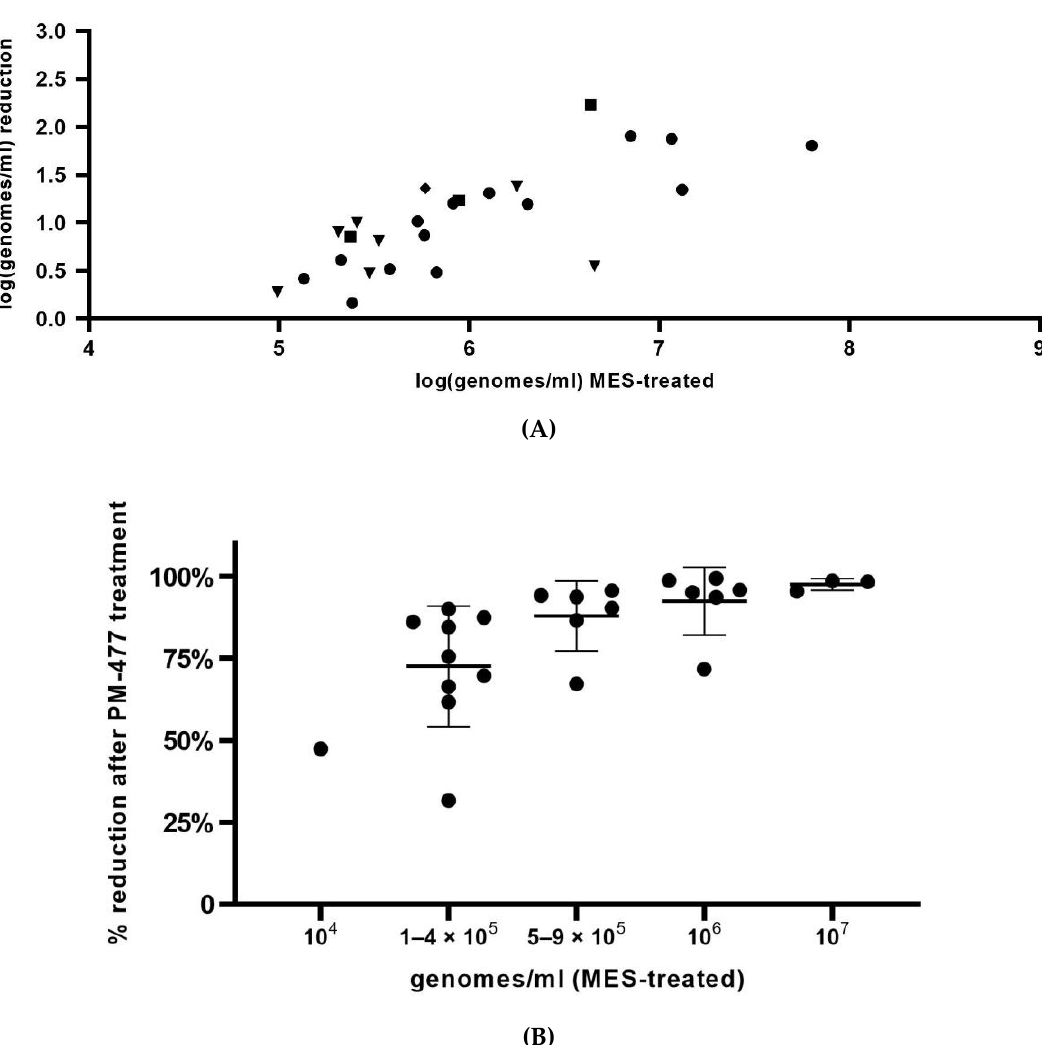
Figure 4. ( A ) Reduction of number of Gardnerella genomes by overnight treatment of vaginal sam- ples with 100 µg/mL PM-477, as assessed by Gardnerella species-specific qPCRs, calculated as: log(MES/PM-477). ( B ) Percentage of reduction of Gardnerella genomes by overnight treatment of vaginal samples with 100 µg/mL PM-477, as assessed by Gardnerella species-specific qPCRs, calcu- lated as: (MES minus PM-477)/MES. MES = number of genomes after treatment of cells with MES and inactivation of free DNA with PMAxx and PM-477 = number of genomes after treatment of cells with PM-477 and inactivation of free DNA with PMAxx. Legend: triangle: G. leopoldii , rhombus: G. piotii , square: G. swidsinskii , circle: G. vaginalis .